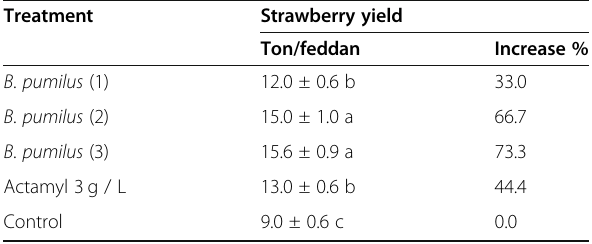
Table 4 Effect of three Bacillus pumilus isolates on strawberry yield under field conditions Treatment